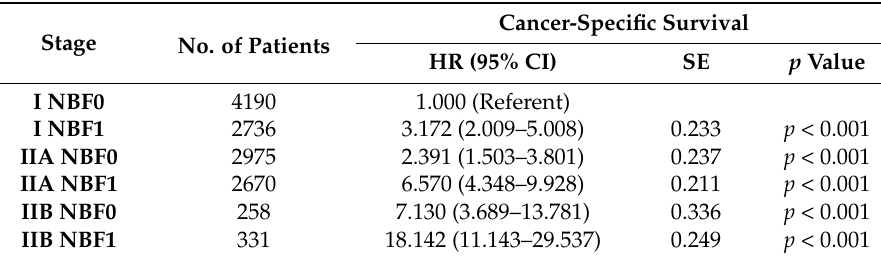
Table 4. Prognosis of NBF-TNM stage in colon